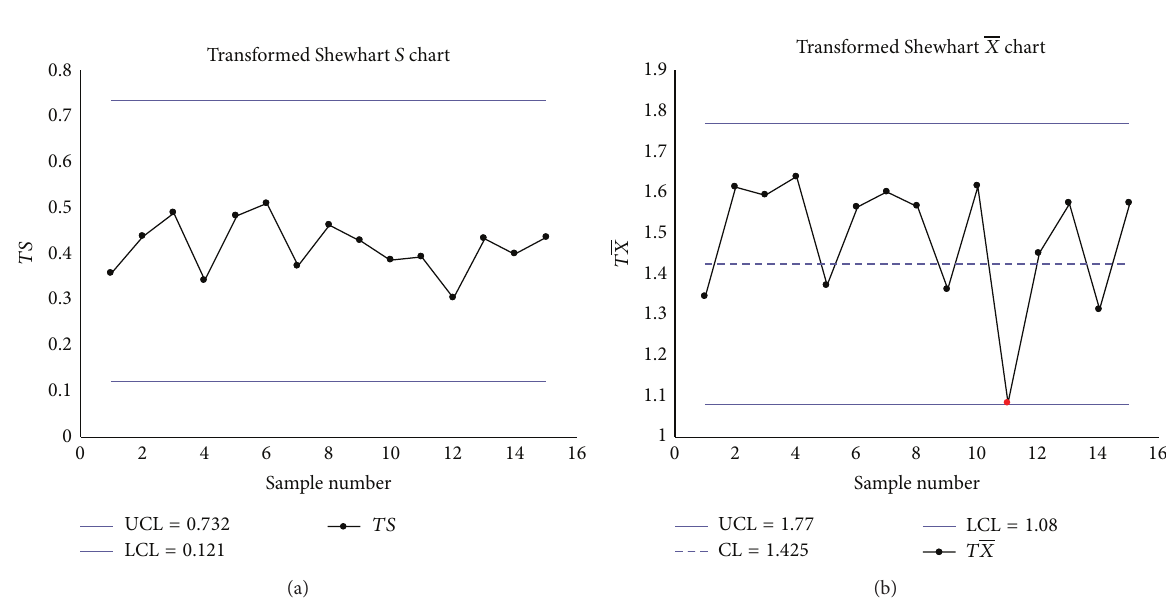
Figure 3: (a) The transformed Shewhart 𝑆 chart. (b) The transformed 𝑋